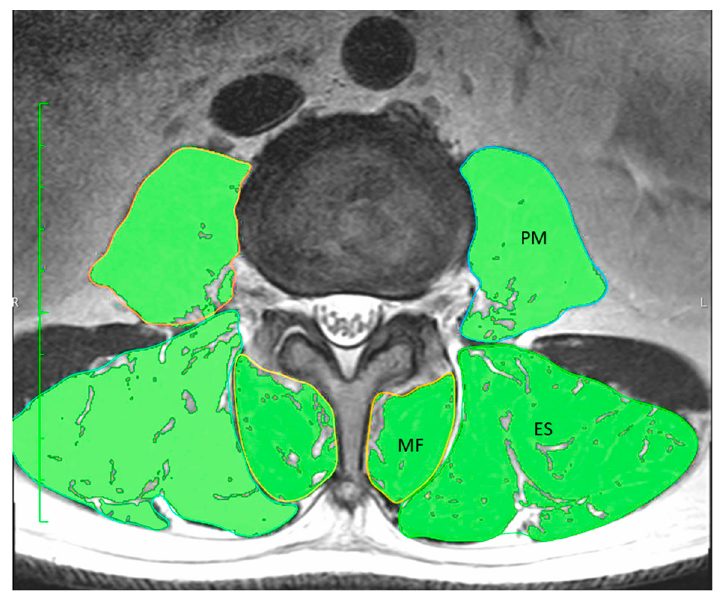
Figure 6. Case presentation 1. A 67-year-old male with no symptoms of low back pain had a CSA of PVM and fat-free PVM of 75.4 and 68.04 cm 2 , respectively. The fat-free percentage of PVM was 90.2%. CSA, cross-sectional area; PVM, paravertebral muscles.